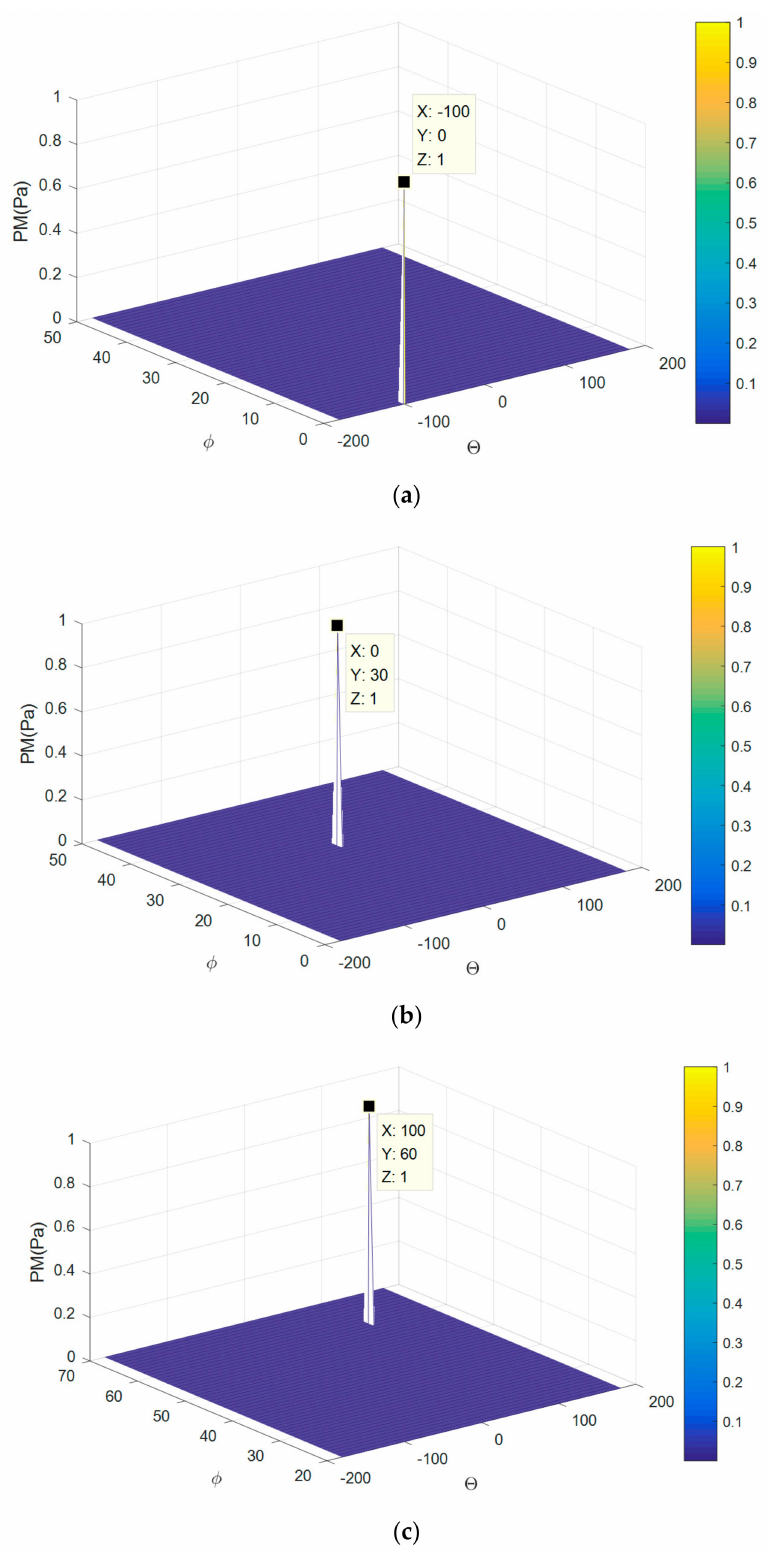
Figure 3. The spherical coordinates of 1 kHz sound source locations: ( a ) ( θ , ϕ ) = ( − 100,0 ) ; ( b ) ( θ , ϕ ) = ( 0,30 ) ; ( c ) ( θ , ϕ ) = ( 100,60 )